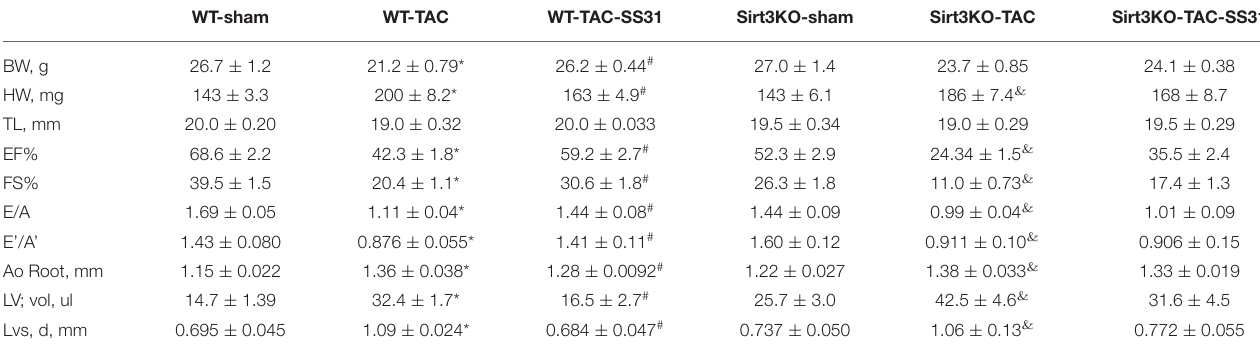
TABLE 1 | SS31 improves the related indexes of heart structure and function in wild-type mice. WT-sham WT-TAC